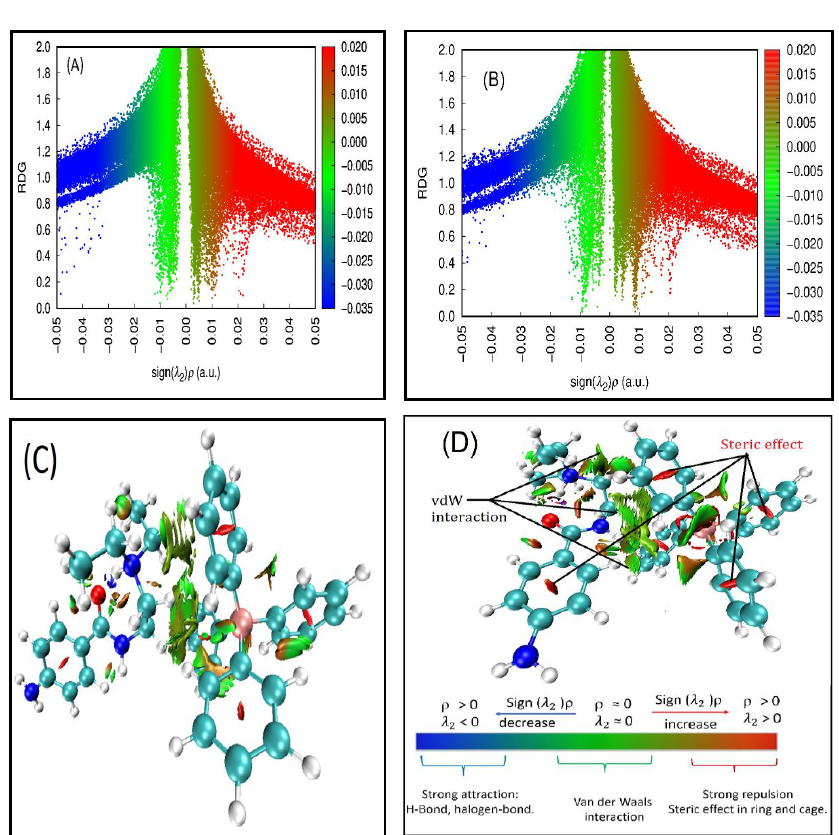
Figure 6. Standard NCI index representations and RDG scatter plots ( A , B ) at the B3LYP/6-311G level. The RDG cut- off is sign(λ 2 )ρ = 0.5 a.u, and the color scale is -0.030 to 0.02 a.u, (blue, green, and red surfaces imply attracting, van der Waals, and repulsive interactions, respectively) for both S1 and S2 configurations, and ( C , D ) isosurface maps for both S1 and S2 configurations, respectively. In addition, the NCI plot is utilized in Figure 6C,D to illustrate van der Waals inter- actions and steric effects of the investigated complex. Notably, the complex molecules contain aromatic moieties that appear to be engaged in the van der Waals contact with the strong RDG spikes seen in green between the molecules in Figure 6C,D. In addition, the orientation of the PR to TPB differed between the two configurations; in the S1 configura- tion, the amine group in the chain terminal was oriented to TPB and interacted with TPB, whereas in the S2 configuration, the NH of the amide group in the middle of the molecule was oriented to TPB and interacted with the TBP ion. In the S1 configuration, there were eight van der Waals interactions between TPB and PR ions, but in the S2 configuration, there were only seven van der Waals interactions (Table 6) [31].